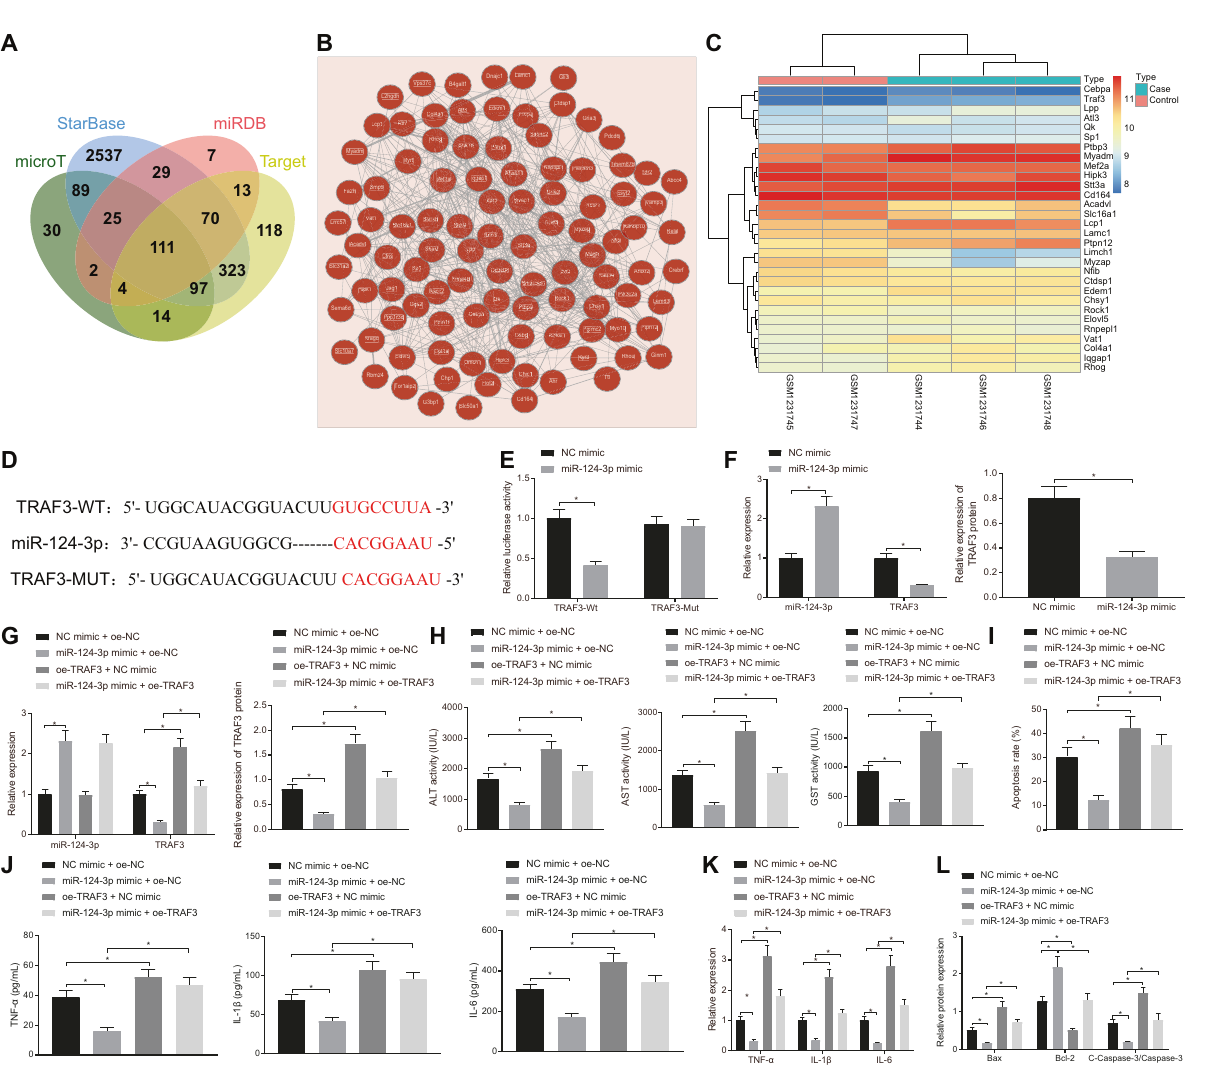
Fig. 3 miR-124-3p downregulates the expression of TRAF3 and thus inhibits H 2 O 2 -induced hepatocyte apoptosis and release of in fl ammatory factors. A The Venn map for intersecting downstream target genes of miR-124-3p predicted on bioinformatics websites, microT, starBase, miRDB, and TargetScan. B The co-expression network of the 111 candidate target genes obtained from the Coexpedia website. C Differential expression of the 30 genes (with a high score in co-expression network) in the GSE50884 dataset. D The binding site between miR-124-3p and TRAF3 predicted by the starBase website. E The targeting relationship between miR-124-3p and TRAF3 veri fi ed by dual-luciferase reporter gene assay. F The expression of TRAF3 in the presence of miR-124-3p mimic detected by RT-qPCR and Western blot analysis. G The expression of miR-124-3p and TRAF3 in hepatocytes in the presence of miR-124-3p mimic, oe-TRAF3 or miR-124-3p mimic + oe-TRAF3 detected by RT-qPCR and Western blot analysis. H Serum levels of GST, ALT, and AST in hepatocyte supernatant in the presence